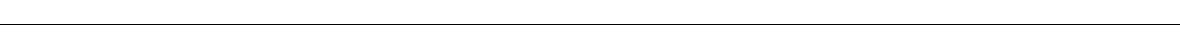
Fig. 5 Actin cap induced reduction of nuclear stress by focusing focal-adhesion forces on the periphery of the cell. a Organization of an actin cap and actin cap-associated focal adhesions in a MEF. Nucleus (blue), F-actin (green), and vinculin-stained focal adhesions (red) were visualized by maximum intensity projection of the z -stacked immuno fl uorescence confocal images. Vertical cross-section depicts the characteristic topology of the actin cap. Parallel- aligned actin cap (yellow arrowhead) are terminated by actin cap-associated focal adhesions (ACAFAs) at the basal surface of the cell, which are larger than the conventional focal adhesions (CFAs). b , c 3D fi nite element model of an adherent MEF. Cross-section (yellow dotted line) of continuum solid elements for cytoplasm reveals a perinuclear region, a continuum solid for nucleus, and 3D beams of the actin cap ( b ). Red arrows in projected bottom view correspond to the linear stretch equivalent to 8% strain ( c ). d – g Effects of the actin cap on the forces acting on focal adhesions under stretching. Vector results of the force in the focal adhesions are depicted in the cell model in the absence ( d ) and presence ( e ) of an actin cap. Radial distribution of reaction forces at focal adhesions ( f ) and the average values ( g ) were calculated depending on the formation of an actin cap in f and g , 56 focal adhesions included in the cell model were assessed. h – j Nuclear stress distribution in the stretched cell. Isometrics of von-Mises stresses in the absence ( h ) and presence ( i ) of an actin cap reveal that external forces are ~30% less transferred to the nucleus of the actin cap forming cell than the actin cap absent cell ( j ). In h and i , the cross-sectioned nuclei were color-coded to clearly show the stress distribution, where scale bars indicate the magnitude of mises stresses. In j , to facilitate quantitative comparison, nuclear stress was expressed as von-Mises stress that represent a non-directional scalar quantity. Values were extracted from 19,248 different nodes inside the nucleus. In f , g , and j statistical analyses were performed using the unpaired t -test, where error bars represent S.E.M. of averaged values; *** p < 0.0001, * p <